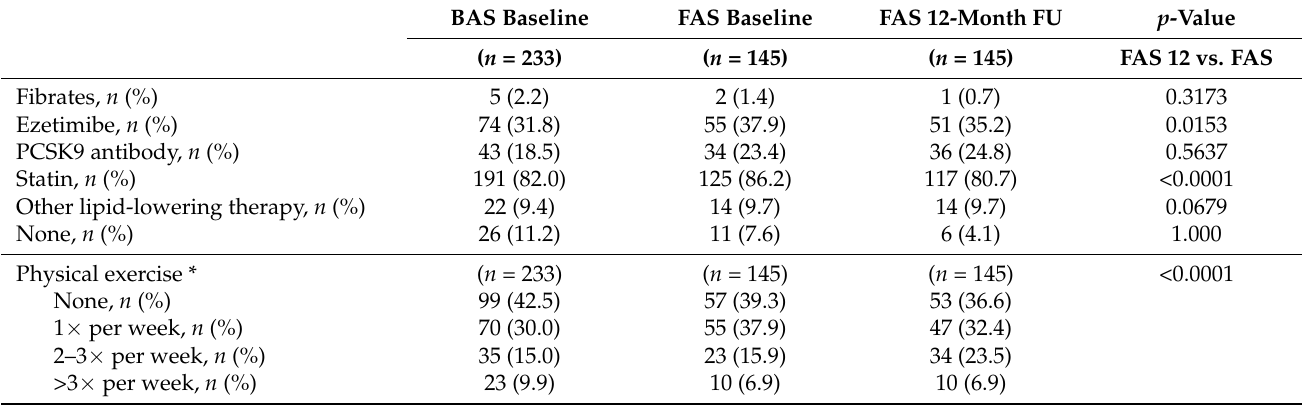
Table 2. Lipid-lowering therapy in the BAS and